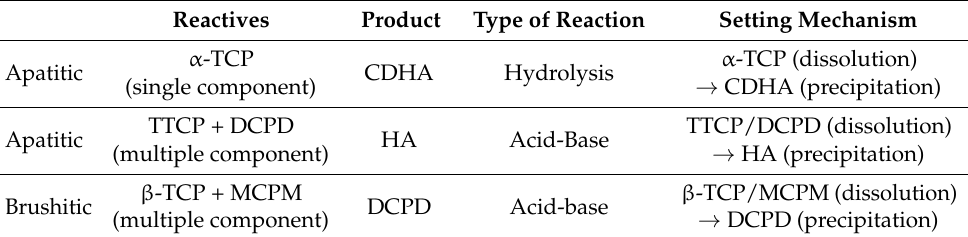
Table 4. List of relevant CPCs and characteristics of their